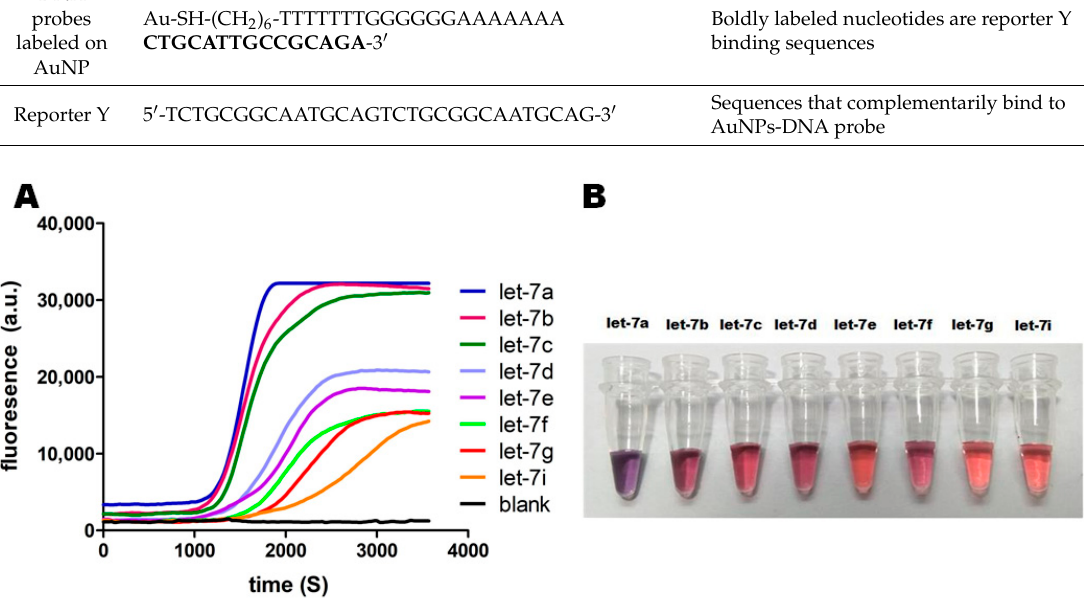
Figure 6. The specificity of EXPAR-AuNPs visual detection. ( A ) Real-time EXPAR fluorescence signals of different let-7 miRNA family members; ( B ) EXPAR-AuNPs visual detection of different let-7 miRNA family members.